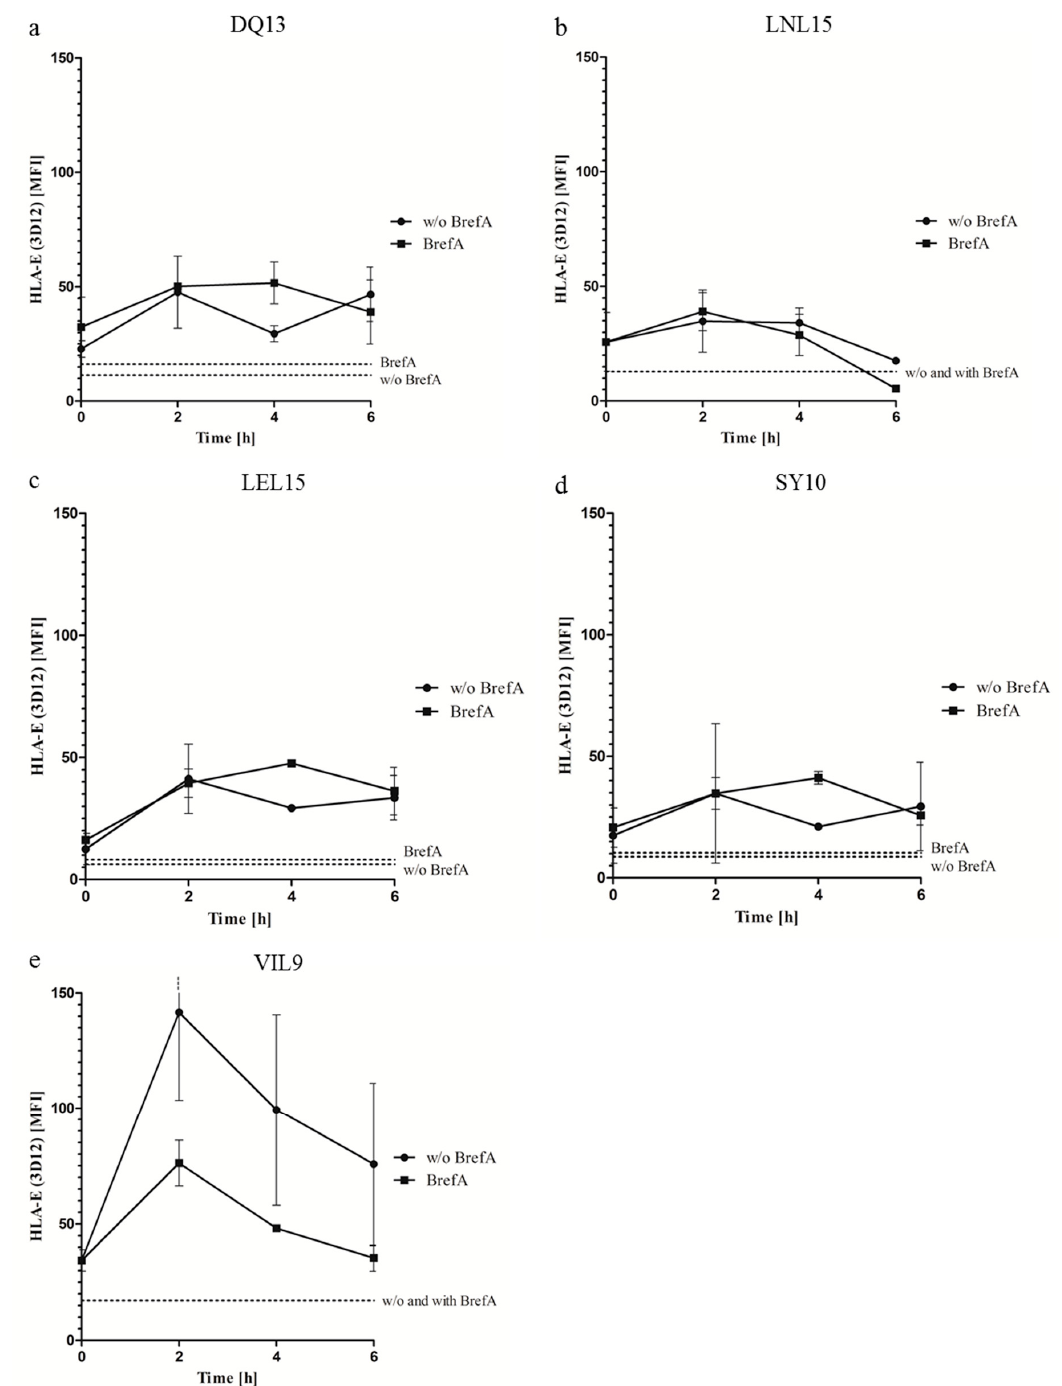
Figure 1. Surface stability of distinct p:HLA-E complexes over a time period of 6 h. T2E cells pre-loaded with one of the five test peptides ( a – e ) was incubated with or without BrefA. Binding of the HLA-E specific mAb 3D12 to these cells was analyzed by flow cytometry over 6 h. The depicted values at each time point are the means of three independent experiments ± SEM. The dashed lines indicate the MFI after 50% of the complexes decayed. The crossing of a curve with this line marks the DT 50 (reported in Table 2). BrefA: Brefeldin A.